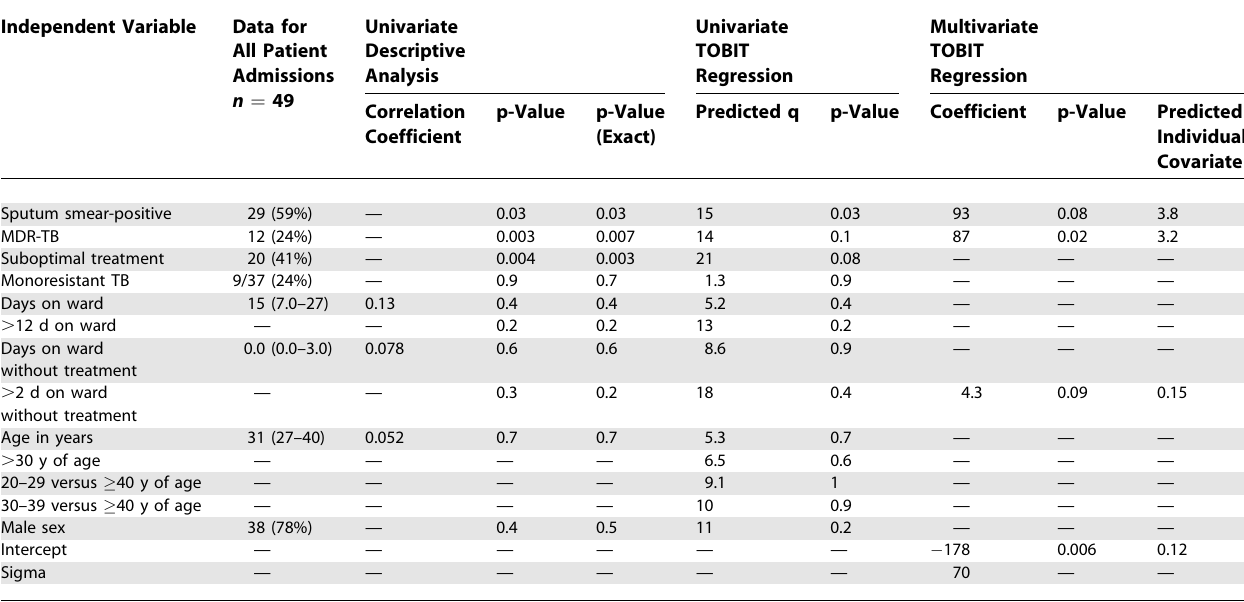
Table 4. Determinants of Patient Infectiousness: Analysis of the Degree of Infectiousness Independent Variable